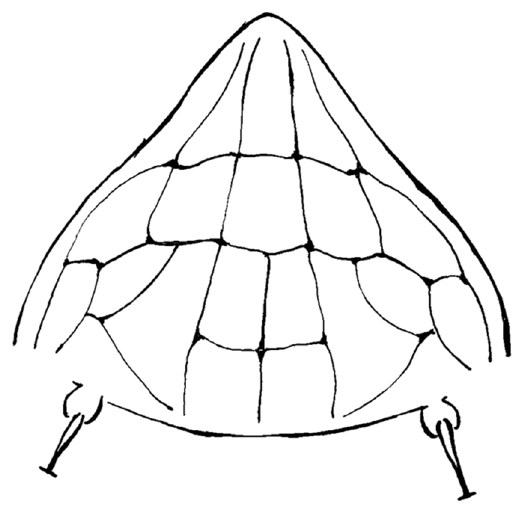
Figure 3. Scanning electron micrographs of a protogyne ( A ) and a deutogyne ( B ) of Aculus mosoniensis . Prodorsal shield and part of dorsal opisthosoma. Scale bars: 10 μ m.